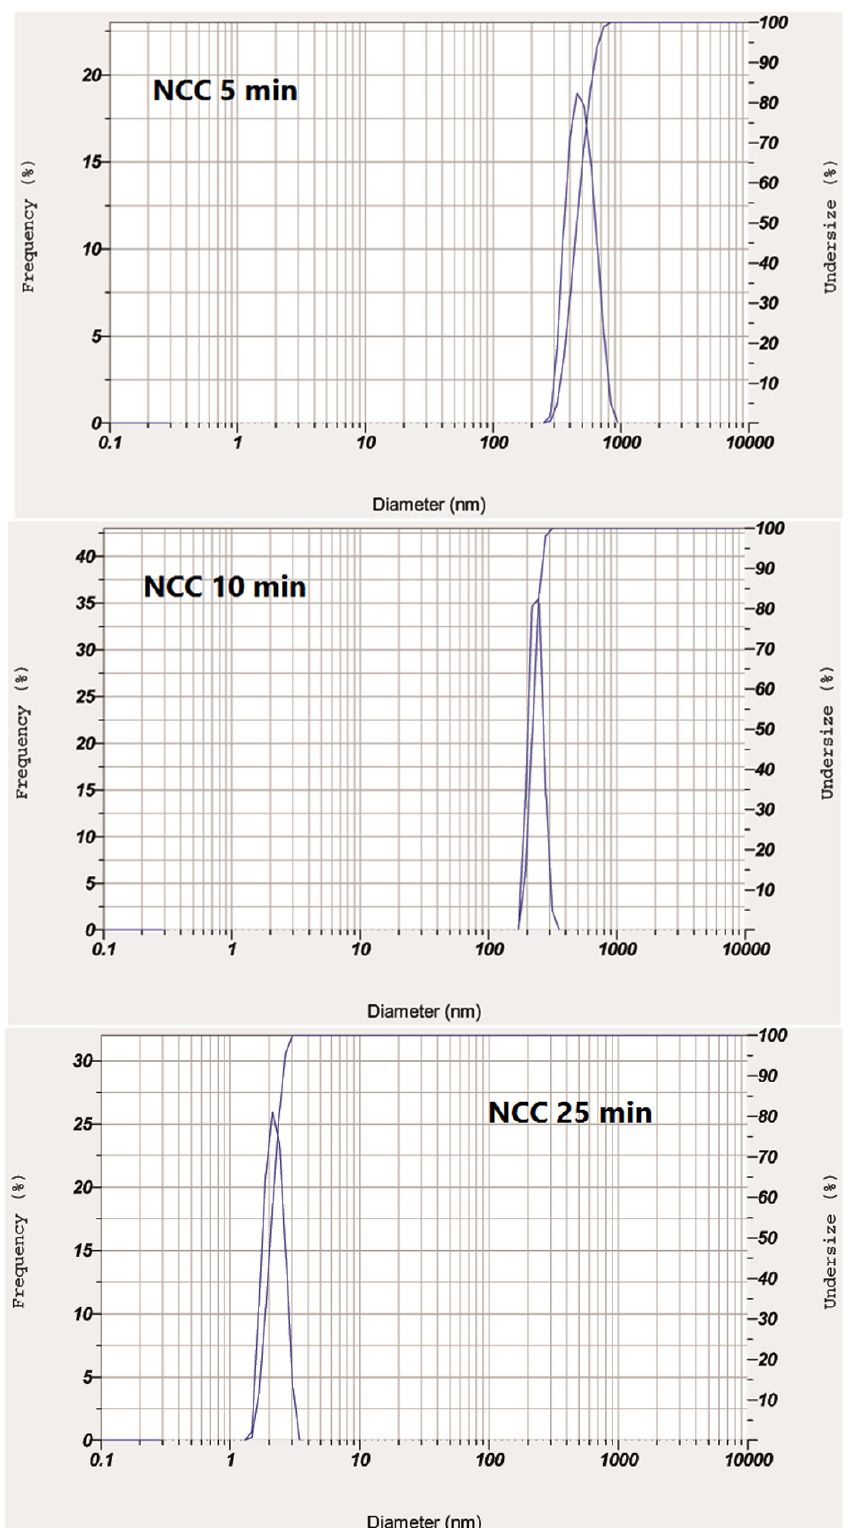
FIGURE 7 - Particle size analyser graphs for NCC polymer at different ultrasonic time points (5 min, 10 min and 25